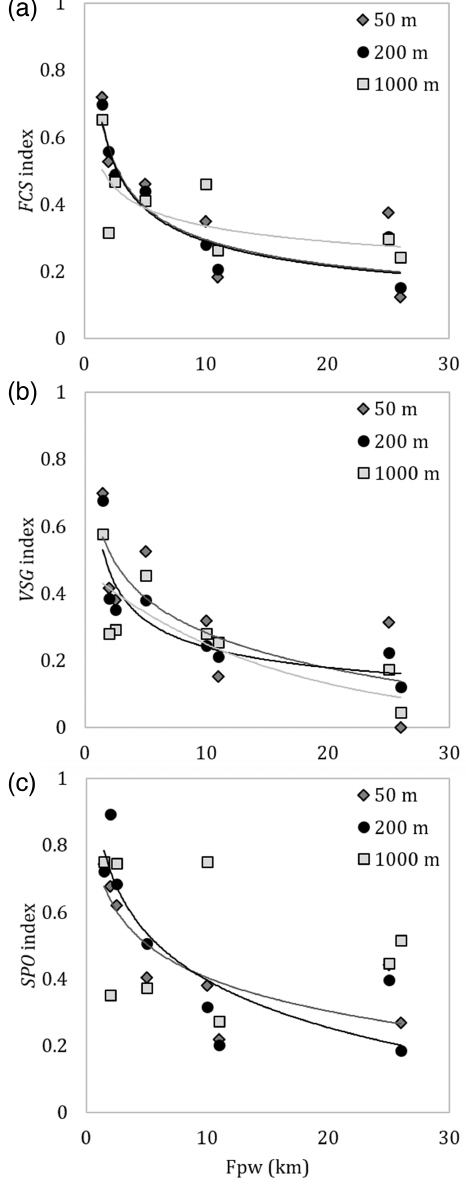
Figure 5. Power relationships between Fpw and (a) FSC, (b) VSG, and (c) SPO at each of the three window sizes.